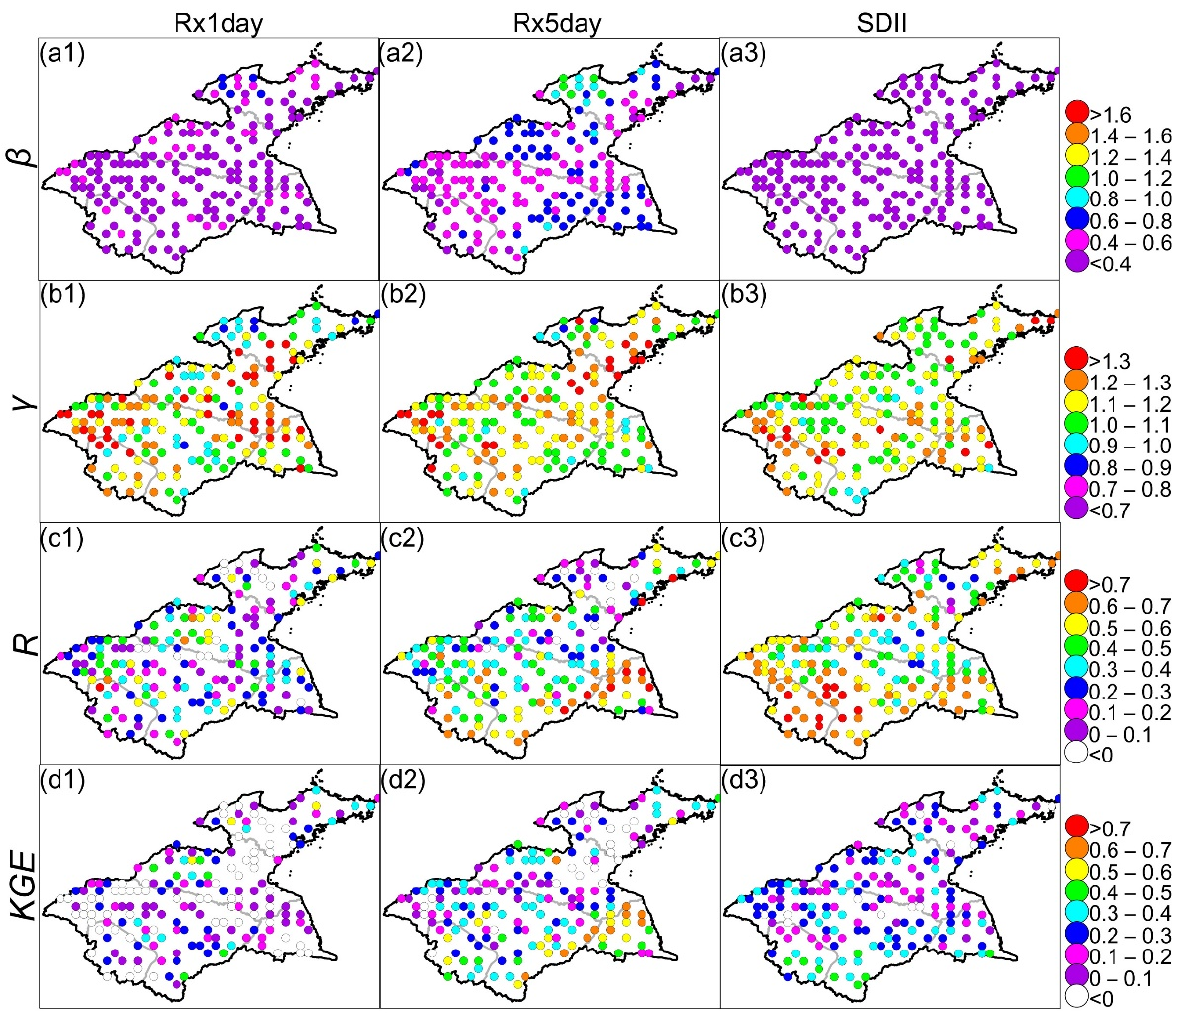
Figure 12. Spatial patterns of different validation metrics for the intensity-based indices. All the observational precipitation intensity-based indices for the HRB increased but at different rates, i.e., 0.23 mm/(day yr) for Rx1day, 0.76 mm/(5 days yr) for Rx5day, and 0.03 mm/(day yr) for SDII (Figure 13a1–a3). Generally, the measured Rx1day in- creased at most (59%) grids, followed by 41% of grids with decreased Rx1day, while the spatial distribution was scattered (Figure 13a1). For the observational Rx5day, 74% of grids corresponded to an increase, particularly in western HRB (excluding southwestern part) with a rate 1.00 mm/(5 days yr), while the remaining grids, generally in the south- western and southeastern parts, showed different reductions (Figure 13a2). There were 34% of grids with decreased SDII, mainly in the southwestern and southeastern parts, followed by increases at the remaining grids (Figure 13a3). Broadly, the HRB β values for the intensity-based indices were all ≤ 0.52, suggesting underestimated trends by the PERSIANN-CDR, especially for Rx5day trends, with many underestimations ( β = 0.20) (Figure 13b1–b3). In terms of the HRB γ , the PERSIANN-CDR underestimated spatial variabilities ( γ < 0.90) for the HRB Rx1day and SDII trends but overestimated ( γ < 1.31) Rx5day trends (Figure 10b1–b3). The PERSIANN-CDR had a certain R -based performance (spatial R around 0.20 or > 0.30) in producing spatial patterns of these indices’ trends (Figure 13b1–b3). There was no ability ( KGE < 0.10) for the PERSIANN-CDR to represent these trends (Figure